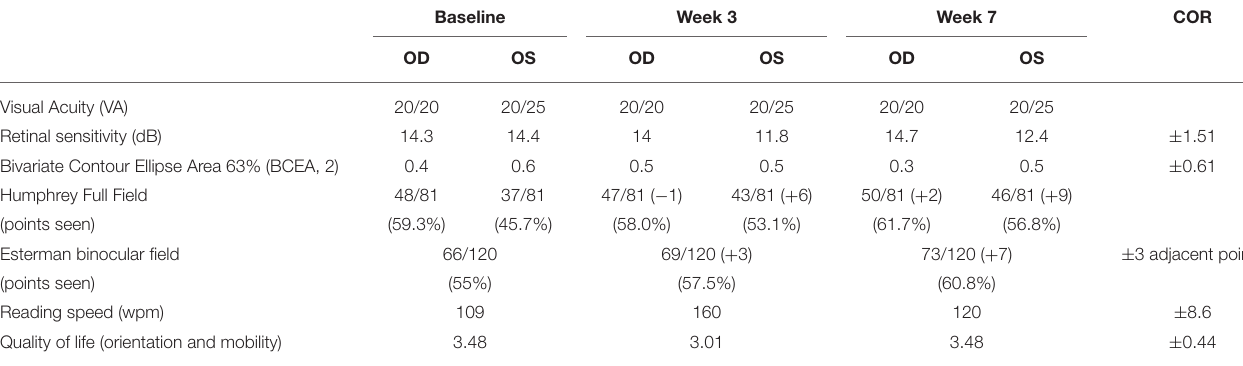
TABLE 2 | Case 1 baseline and after treatment outcome